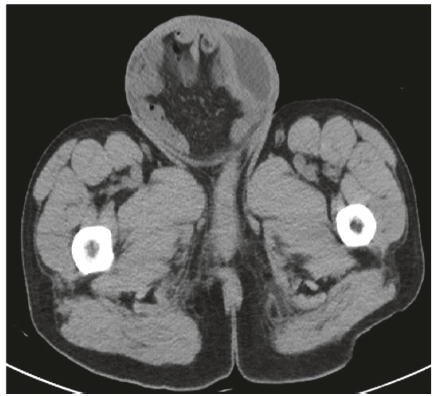
Figure 3: A more inferior CT image demonstrates a portion of the bladder within the very large right inguinal